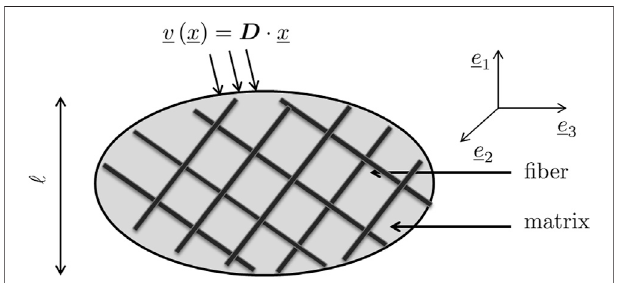
FIGURE 1 | Representative volume element with characteristic length ℓ , subjected to homogeneous boundary conditions in terms of a microscopic velocity fi eld arising from one macroscopic strain rate.